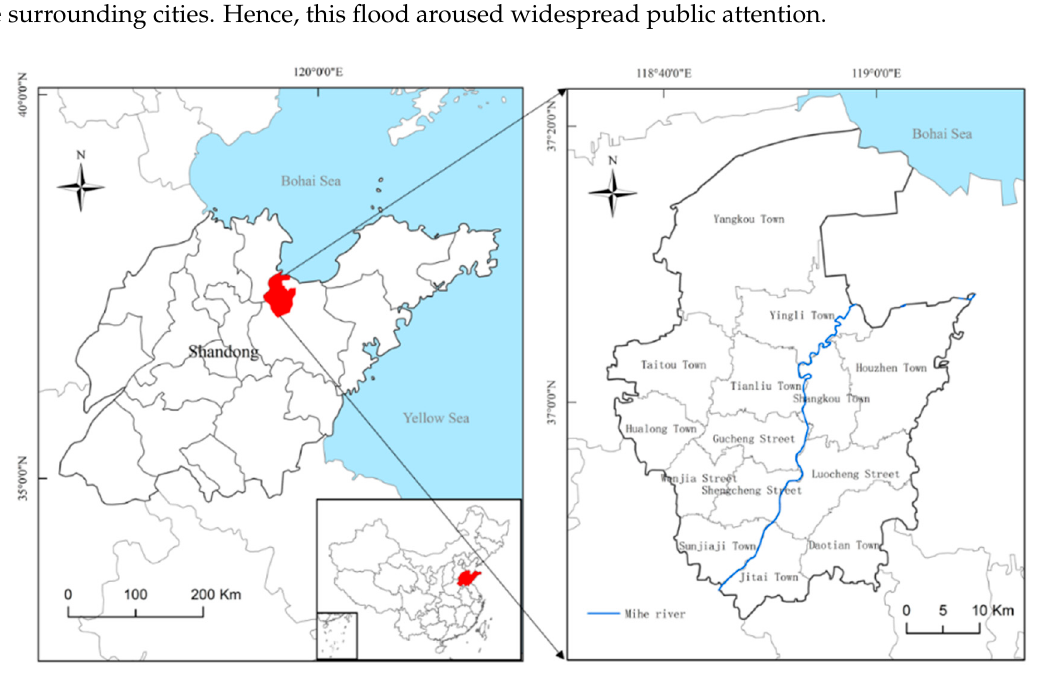
Figure 1. The administrative region of the Shouguang study area.